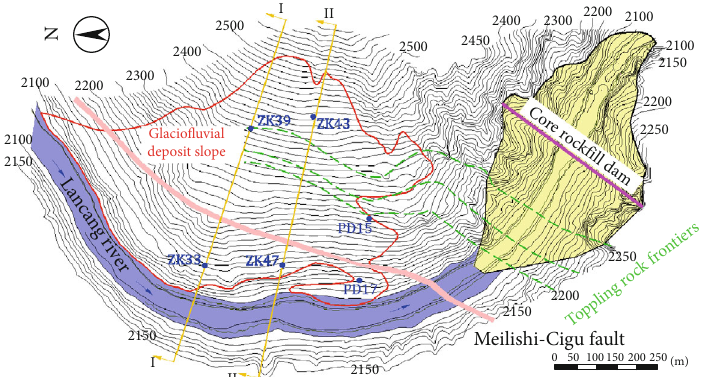
Figure 4: Plane shape map of the glacio fl uvial deposit ahead of the Gushui hydropower station.